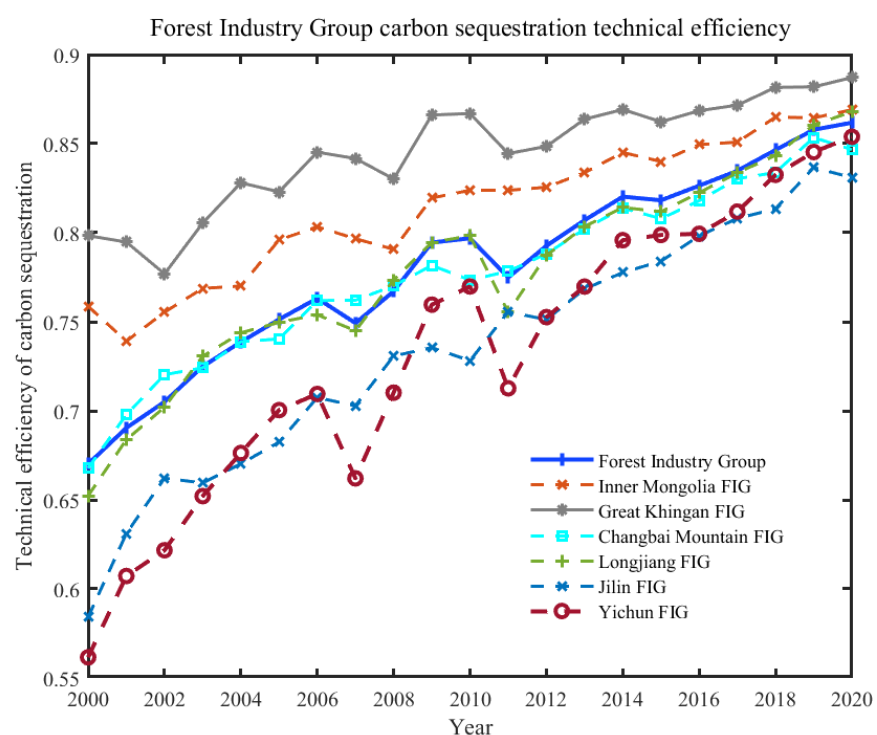
Figure 5. Temporal trend in forest vegetation carbon sequestration technical efficiency of forest industry groups.